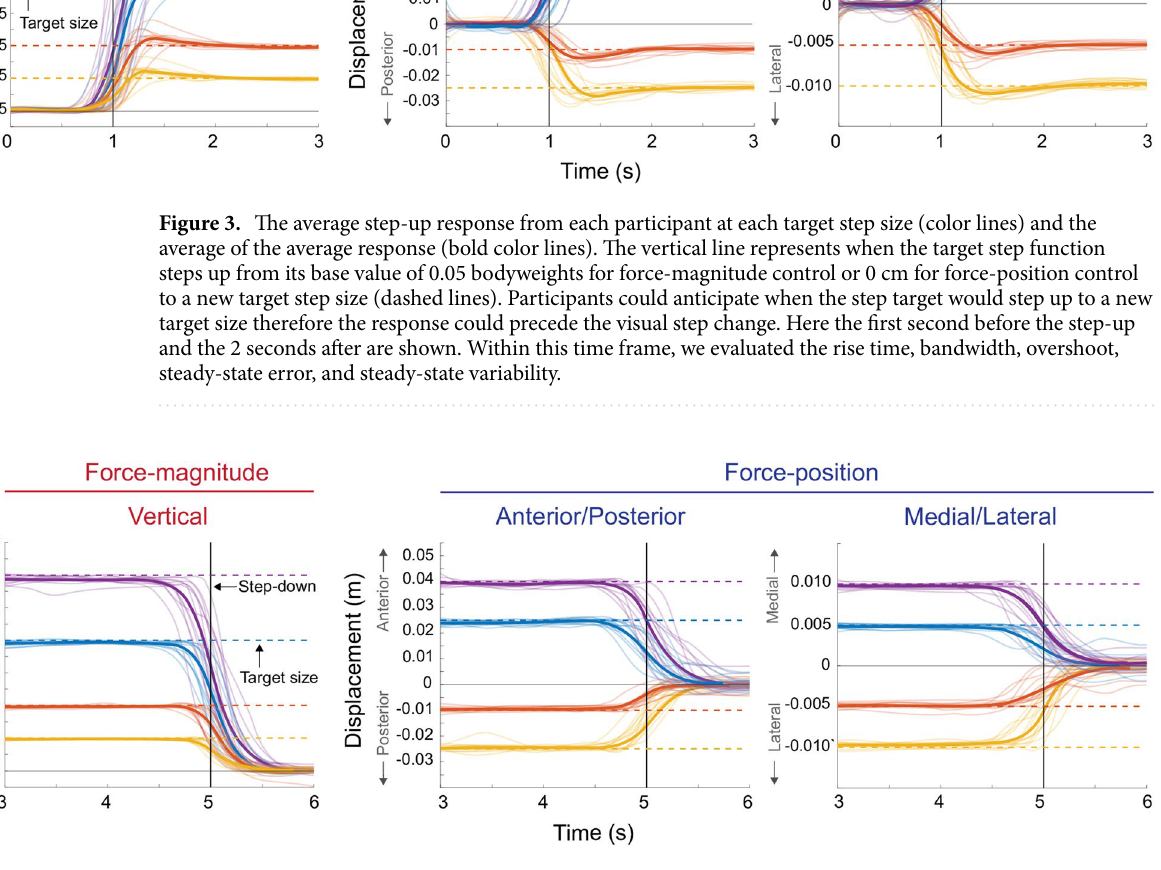
ticipants tended to be less accurate and more variable as demonstrated by increased steady-state error and vari- ability, but these relationships were weak and not significant for most of the conditions. Finally, there were sig- nificant correlations between increases in steady-state variability and increases in steady-state error (p < 0.001) for all the conditions for both force-magnitude and force-position control, but the fits were weak with R at best 0.34 and at worst 0.05. We found no other significant correlations between other measures of control performance. Leg external force control as a second-order control system. A second-order model well described the step-up control characteristics found for the control of leg external forces (Fig. 6). Best-fit R 2 values for all step target sizes in both force-magnitude and position control were above 0.85 (Table 2). We chose the second- order model because the overshooting observed in the data was not a feature that could be described using a first- order model, and a third-order model was unnecessary given how well the second-order model described the observed behavior. The second-order controller for controlling leg external force can be well approximated using the following control parameters: K (process gain) = 1, τ (time constant) = 100 ms, Z (damping constant) = 0.5, and T d (time delay or lead time) = − 100 ms. A controller with these parameters has a rise time of 165 ms, a band- width of 2.0 Hz, overshoots by 16.3%, a settling time of 1.7 s, and no steady-state error or steady-state variability.